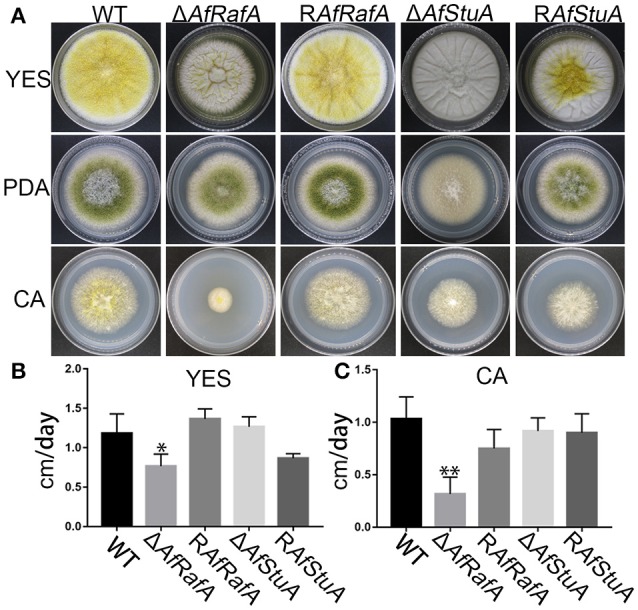
Defects of ΔAfRafA and ΔAfStuA mutants in fungal vegetative growth. (A) Colonies for gene deletion (ΔAfRafA and ΔAfStuA), complementation strains (RAfRafA and RAfStuA), and WT (CA14) cultured on YES, potato dextrose agar (PDA), and Czapek-Dox agar (CA) under 29°C for 6 days. (B) The growth rates of gene deletion and complementation strains on YES agar. (C) Growth rate of all strains on CA agar. We performed this experiment twice and three biological repeats were performed for each replicate. *p ≤ 0.05, **p ≤ 0.01.